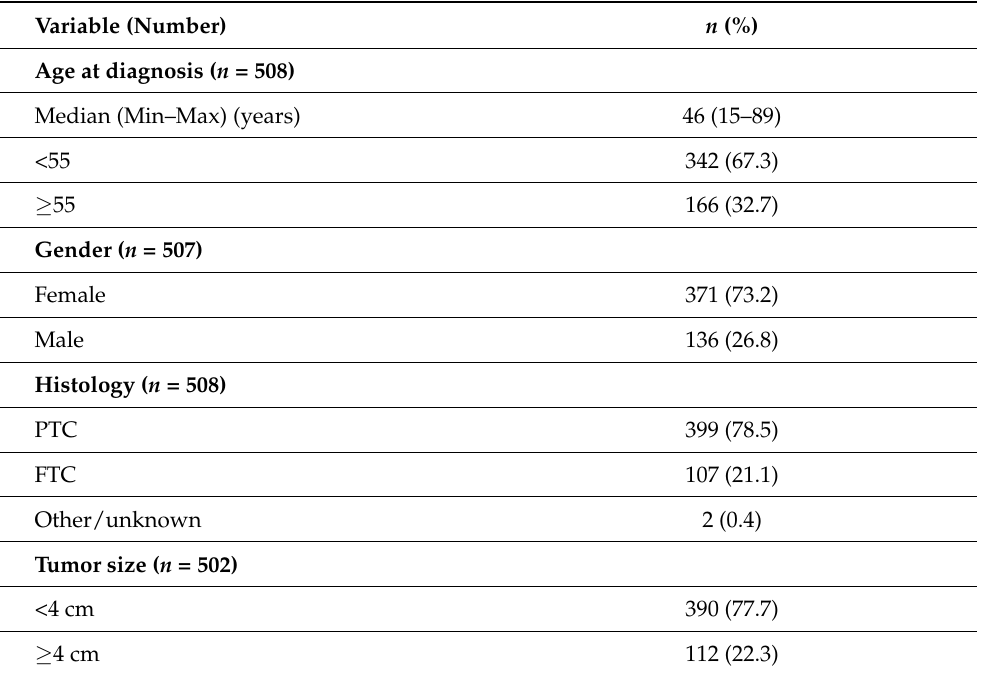
Table 1. Clinic-pathological characteristics for the TCGA TC